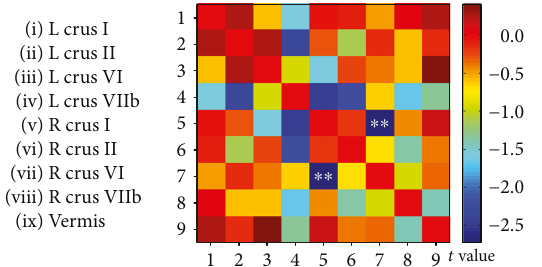
Figure 4: A matrix map of ROI-based interregional functional connectivity (FC) in the cerebellum of the SNHL group and HCs. Compared to HCs, the SNHL group showed a signi fi cant reduction of resting-state FC between right crus I and crus VI ( p < 0 01 , uncorrected). After FWE correction, no signi fi cant di ff erence remained. The colour bar at the right shows t value. ∗∗ p < 0 01